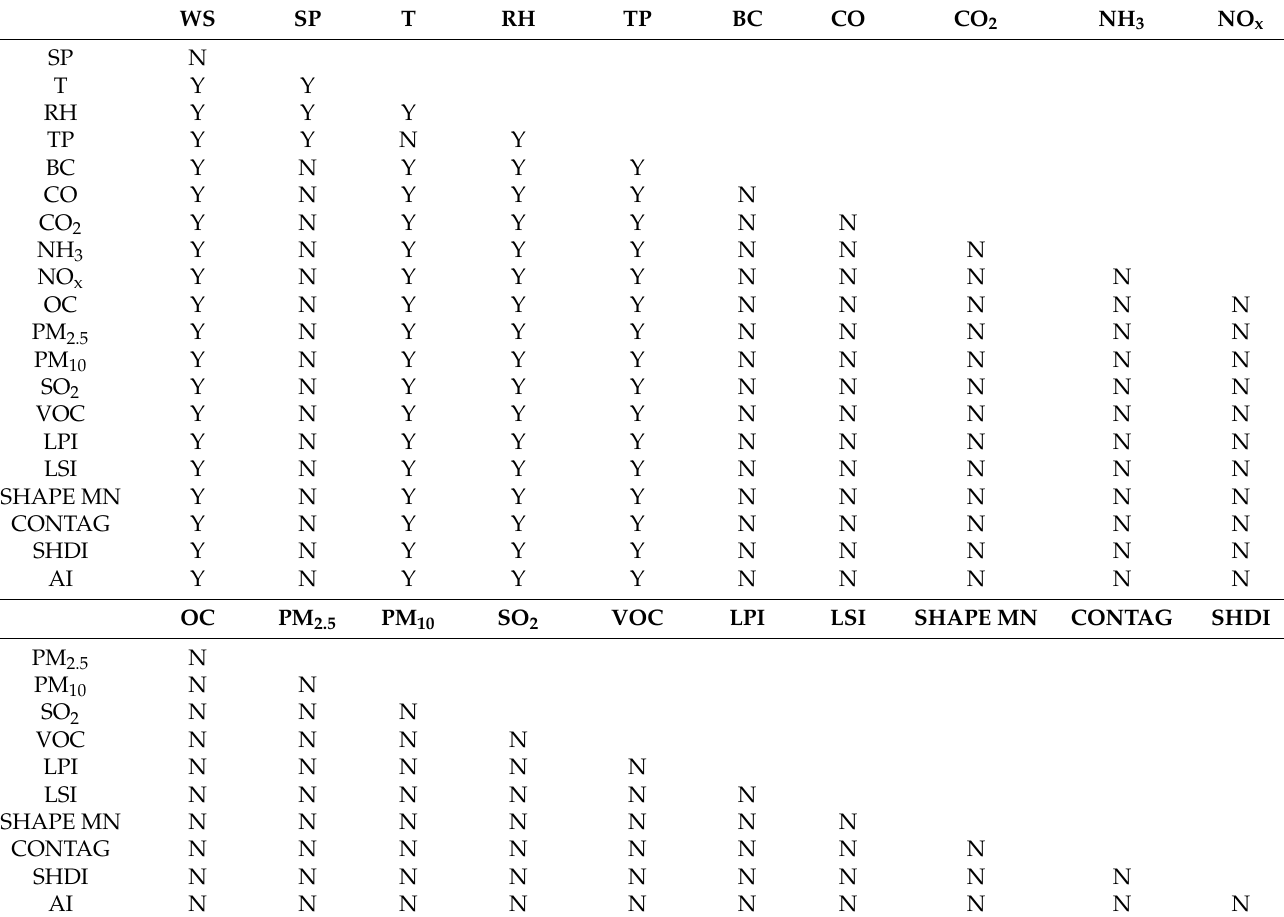
Table A1. Meteorology, emission, and landscape pattern ecological detection results.